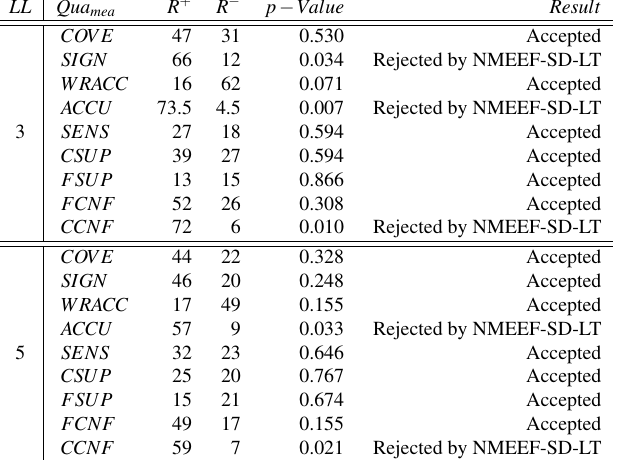
Table 4. Statistical analysis between NMEEF-SD and NMEEF- SD-LT. The comparison performed is NMEEF-SD-LT Vs.